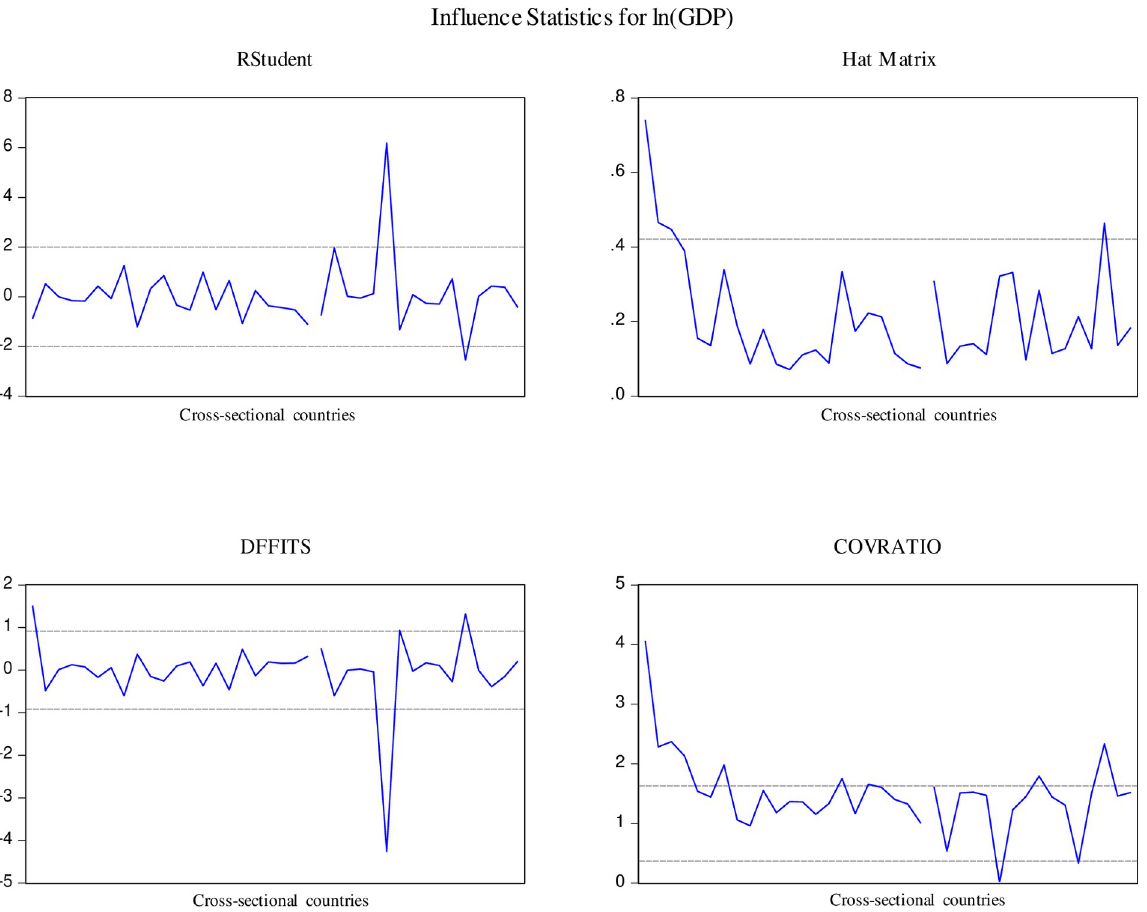
Fig 4. Influence statistics for ln(GDP). Source: Author’s